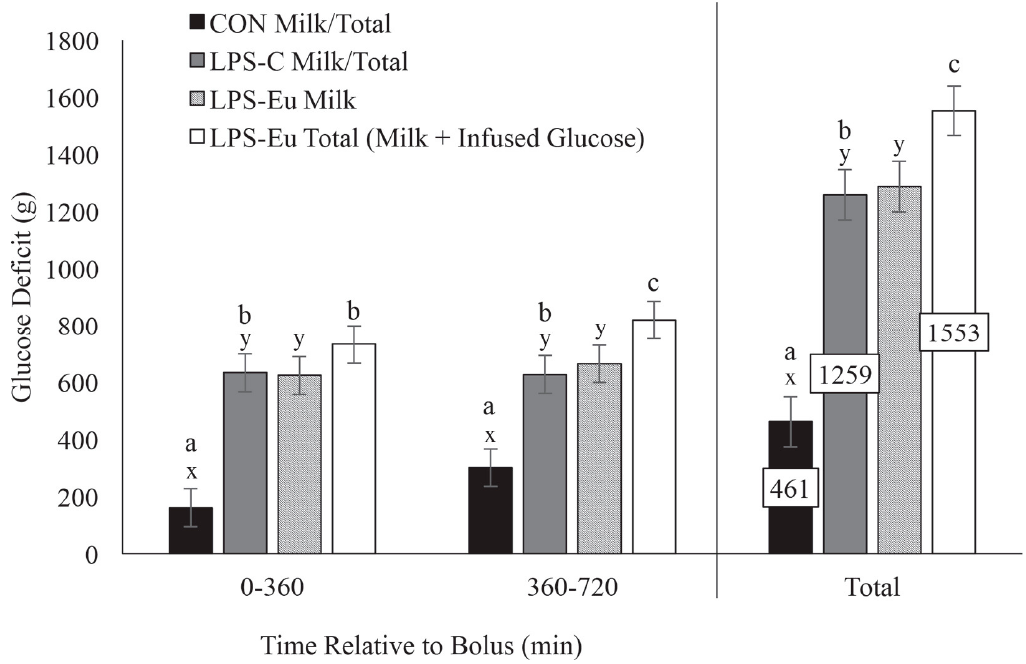
Figure 2. Milk or total glucose deficit from zero to 360, 360 to 720, and accumulated over 720 min in cows administered a bolus of saline (CON), lipopolysaccharide (LPS-C), or lipopolysaccharide accompanied with a euglycemic clamp (LPS-Eu). Di ff erent letters (x,y) represent di ff erences between milk glucose deficits ( p ≤ 0.05). Di ff erent letters (a–c) represent di ff erences between total glucose deficits ( p ≤ 0.05; total glucose deficit = milk glucose deficit in CON and LPS-C cows; total deficit = milk glucose deficit + infused glucose in LPS-Eu cows). Results are expressed as least square means ± standard error of means. Reprinted from Kvidera et al. (2017), Copyright (2017) with permission from Elsevier.